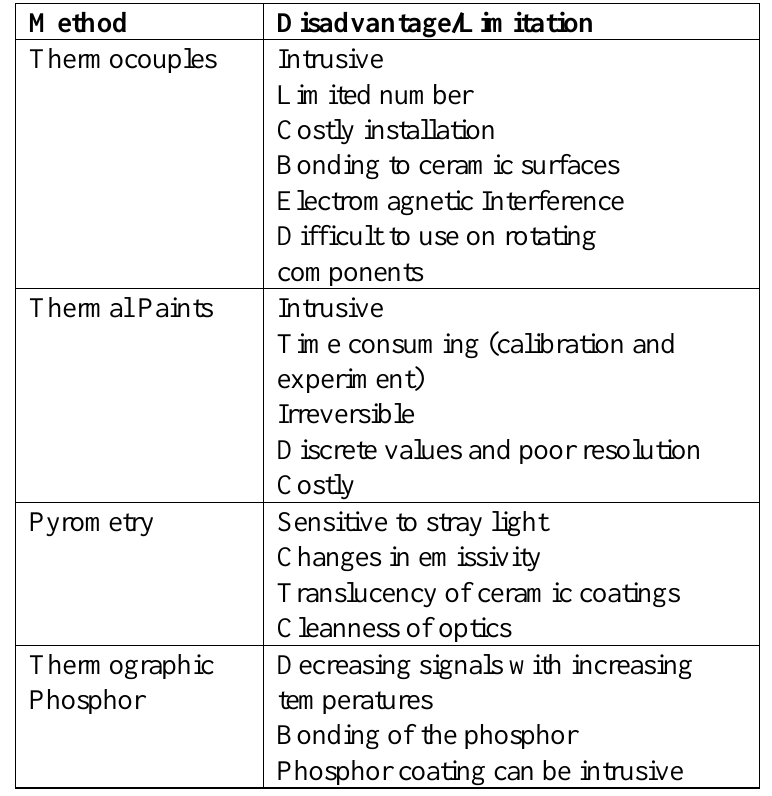
Table 4. Overview of the limitations of the temperature measurement techniques in gas turbines. Taken from Feist et al .